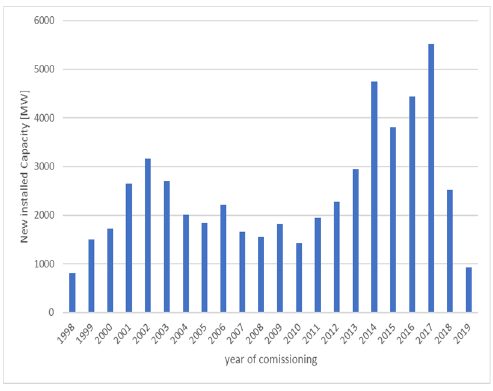
Figure 15. Historical additions for onshore wind power plants in Germany.